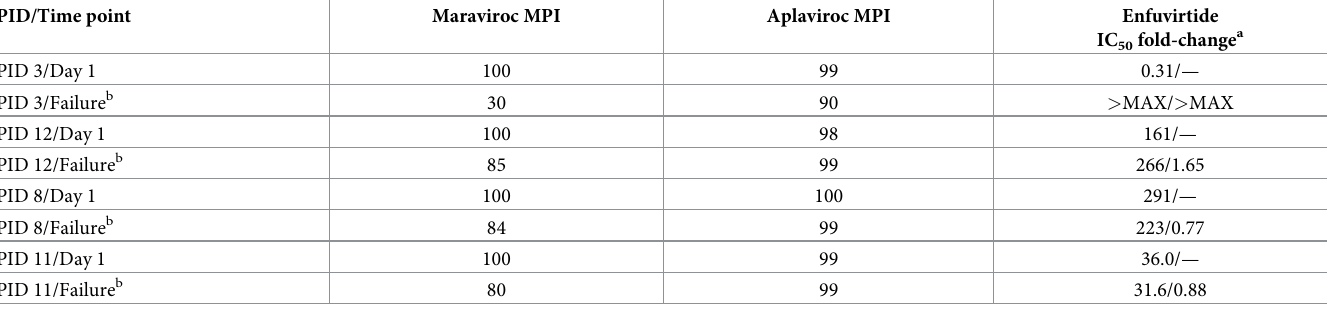
a Fold-change relative to JRCSF reference virus/relative to Day 1. b Optimized background therapy included